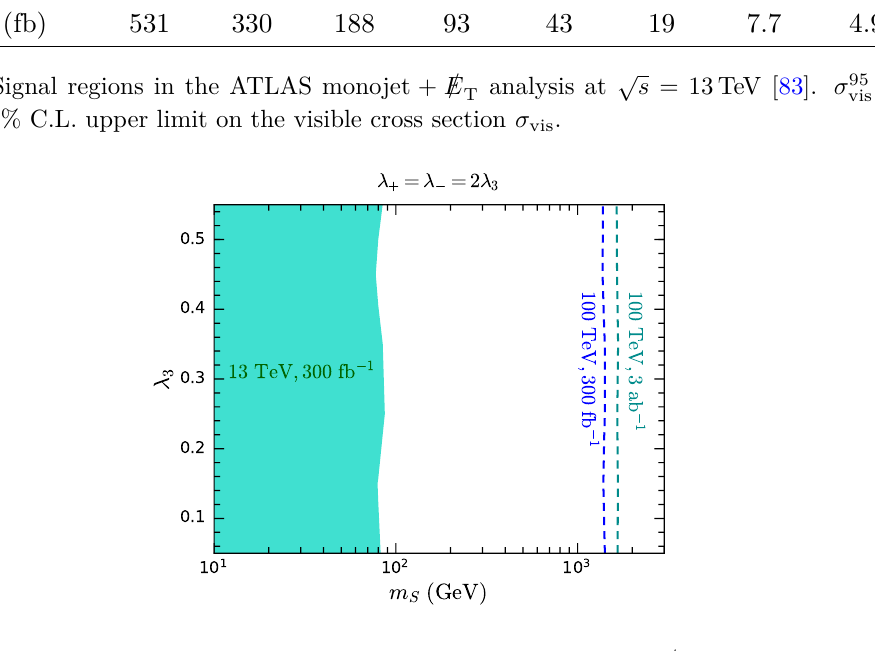
channel in the m S - λ 3 T